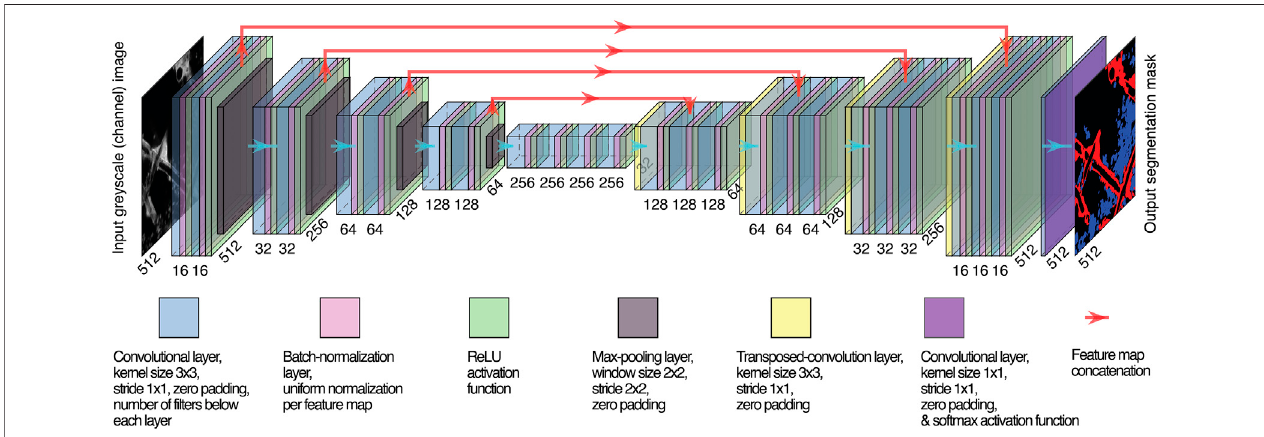
FIGURE1| U-Net variant,networkarchitecture.Thesamenumber oflayerblocksisemployed fortheencoder andthedecoder (intheexample,4) andthenumber of fi lters in each convolutional layer, but the last one maintains the same ratio with respect to the one of the fi rst layer (16, in the example). Spatial dimensions of feature maps and numbers of fi lters are reported, respectively, diagonally and